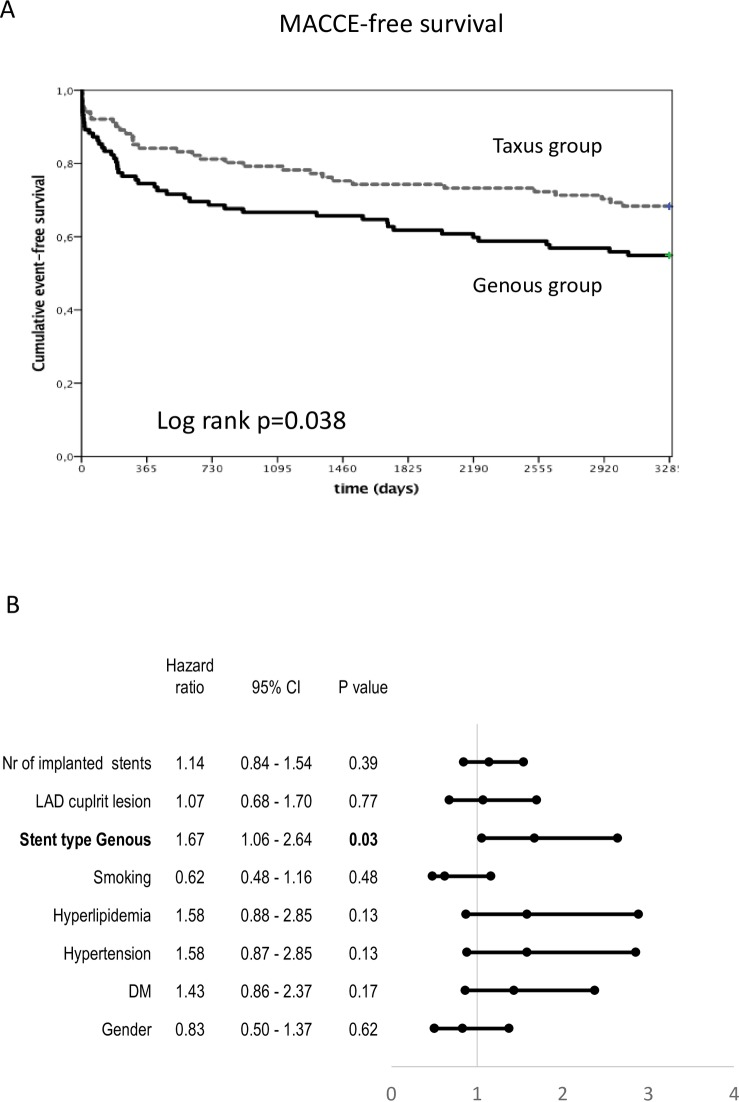
Kaplan-Meier major adverse cardiac and cerebrovascular event- (MACCE)-free survival in patients with STEMI who received Genous or TAXUS Liberté stents in primary percutaneous coronary intervention.(A) Cumulative MACCE-free survival. (B) Forest plot of MACCE-free survival in the indicated subgroups. CI = confidence interval; DM = diabetes mellitus; LAD = left anterior descending coronary artery; Nr = number.